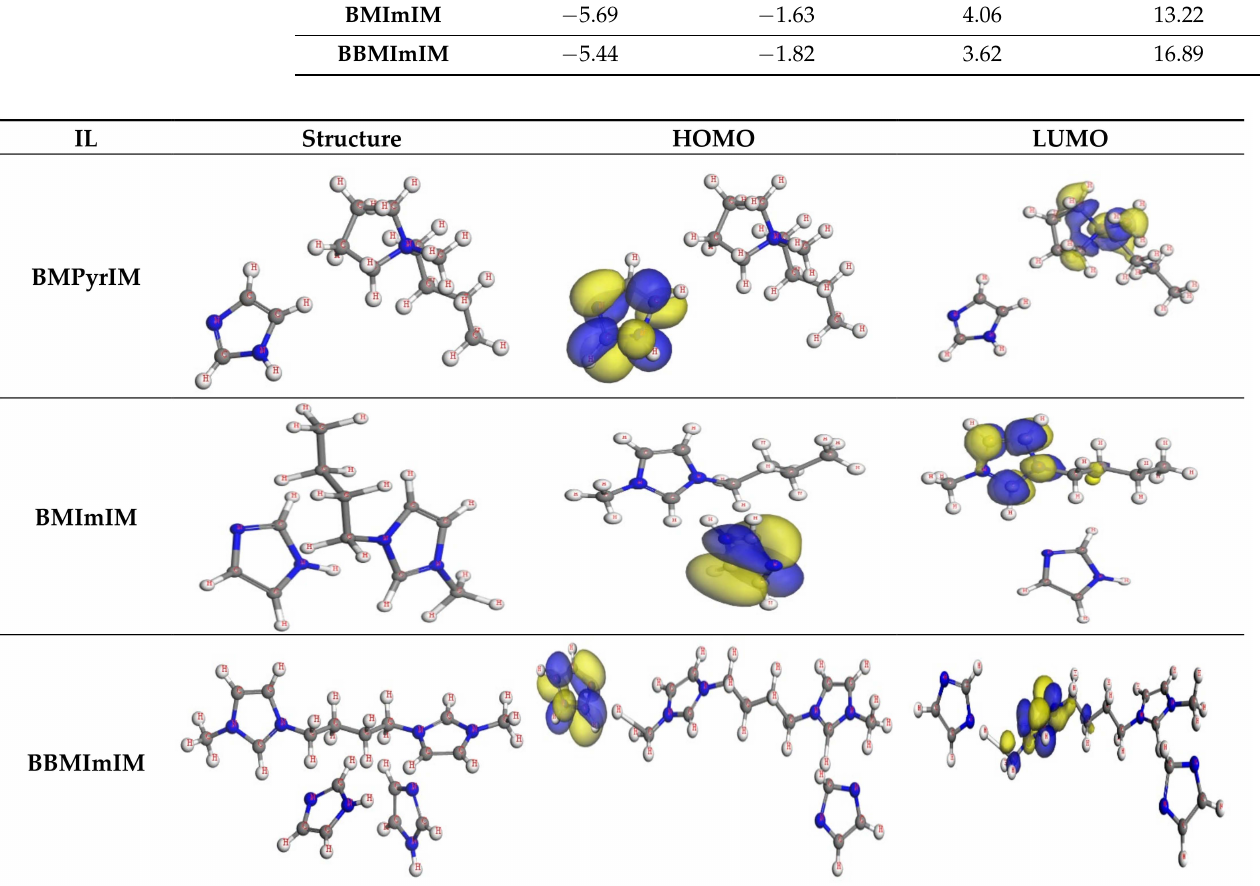
Figure 10. The optimized molecular structures, HOMO and LUMO of the investigated ILs ( BMPyrIM , BMImIM and BBMImIM ). Blue and yellow isosurfaces of the HOMO and LUMO denote positive and negative wavefunction phases, respectively, using Dmol 3